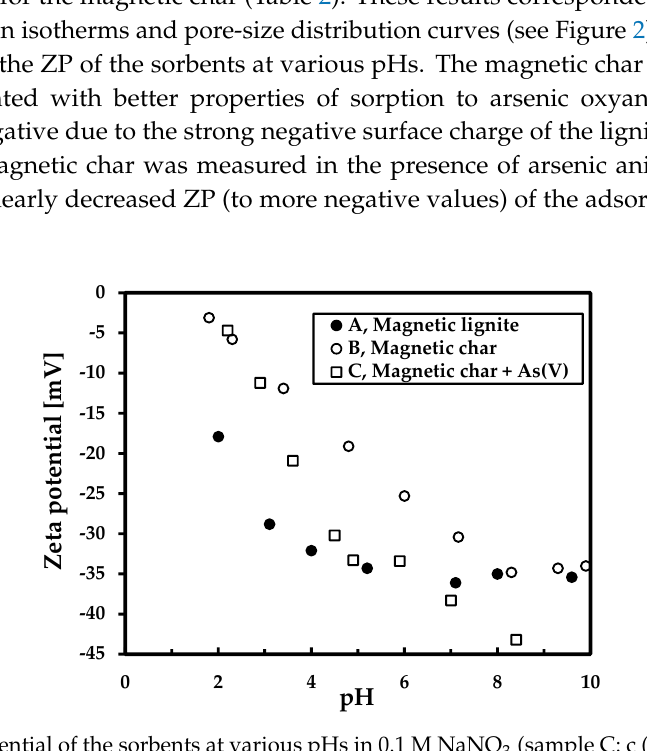
Figure 4. X-ray powder diffraction of the dried ferrofluid, magnetic lignite, and magnetic char (Miller indices for maghemite/magnetite are also indicated).